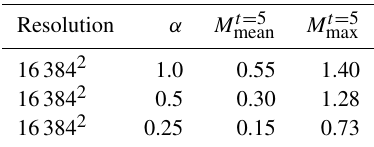
Table 1. The mean and maximum Mach numbers computed at final time t =